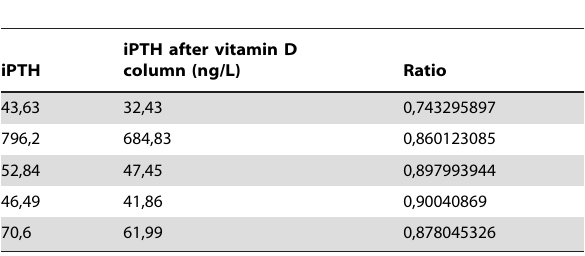
Table 3. Control experiment: PTH was measured directly and after washing of the samples from a vitamin D